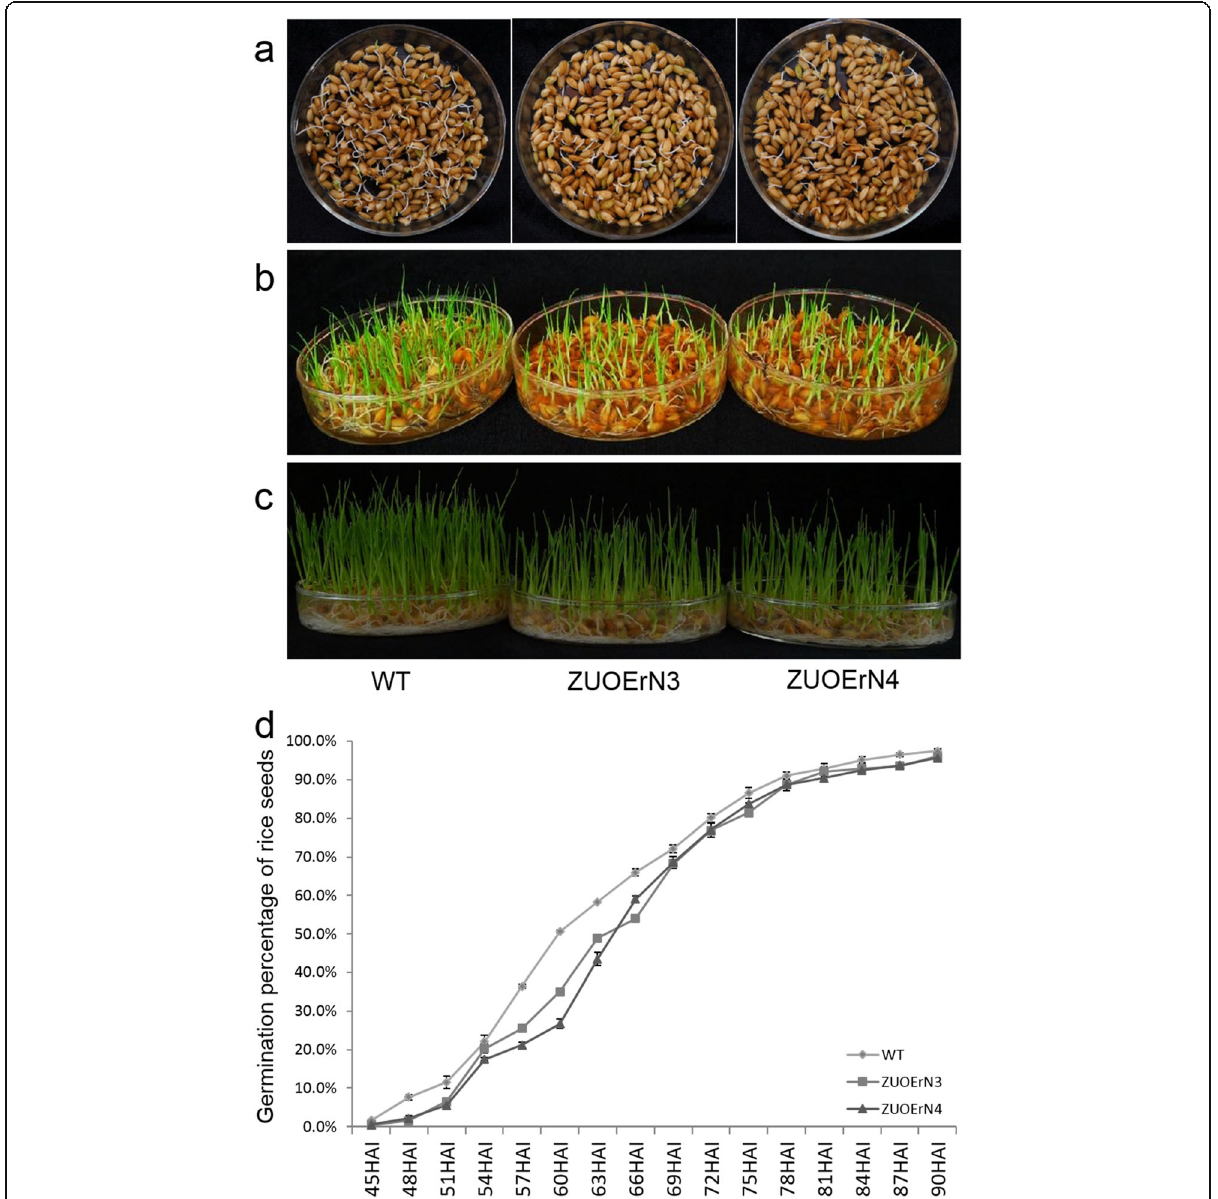
Fig. 1 mOsNAC2 -overexpressing seeds germinate more slowly than those of WT. The seeds were presoaked with distilled water for 48 h and then germinated at 25/23 °C (day/night) in petri dishes. The germination percentage was calculated at different times after imbibition. The images were taken at 3 d ( a ), 7 d ( b ), and 9 d ( c ) after imbibition in water. ( d ) Germination percentage after imbibition in water. WT: wild-type seeds; ZUOErN3 and ZUOErN4: OsNAC2 overexpression lines; HAI: hours after imbibition. Error bars represent SD of three biological replicates ( n > 200). ** P < 0.01 ( t